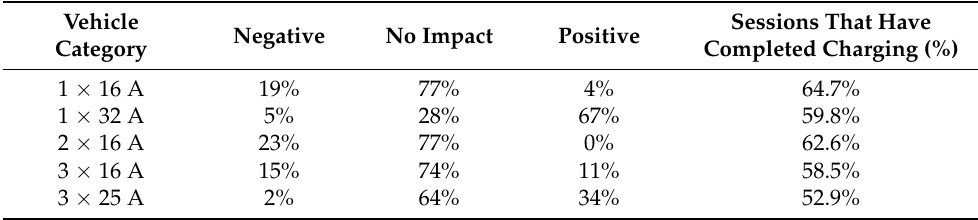
Figure 4. Distribution of the average power per transaction per vehicle category for Flexpower and reference stations. The average is calculated for the whole session, so periods of slower charging during the current limitation can be compensated in the preceding or following hours. Only sessions that have not finished charging upon disconnection are shown (47.3%). Table 2. Percentage of charging sessions that was influenced by Flexpower and how. The numbers only reflect the sessions that were not completed at the moment of